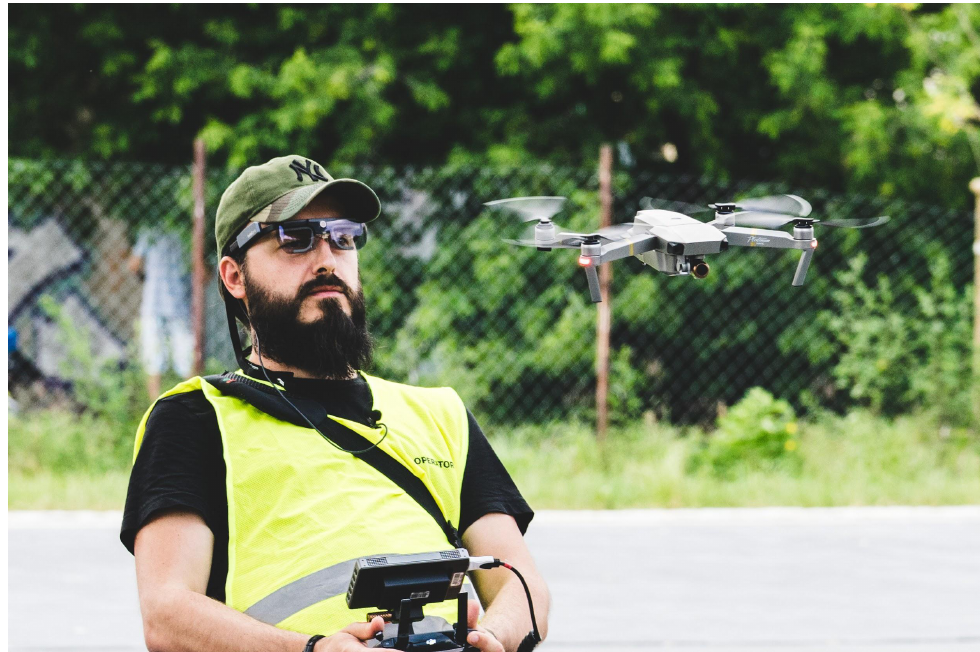
Figure 1. Research participant—Pilot P4 during shot execution; Photograph by Jarek Królikowski/